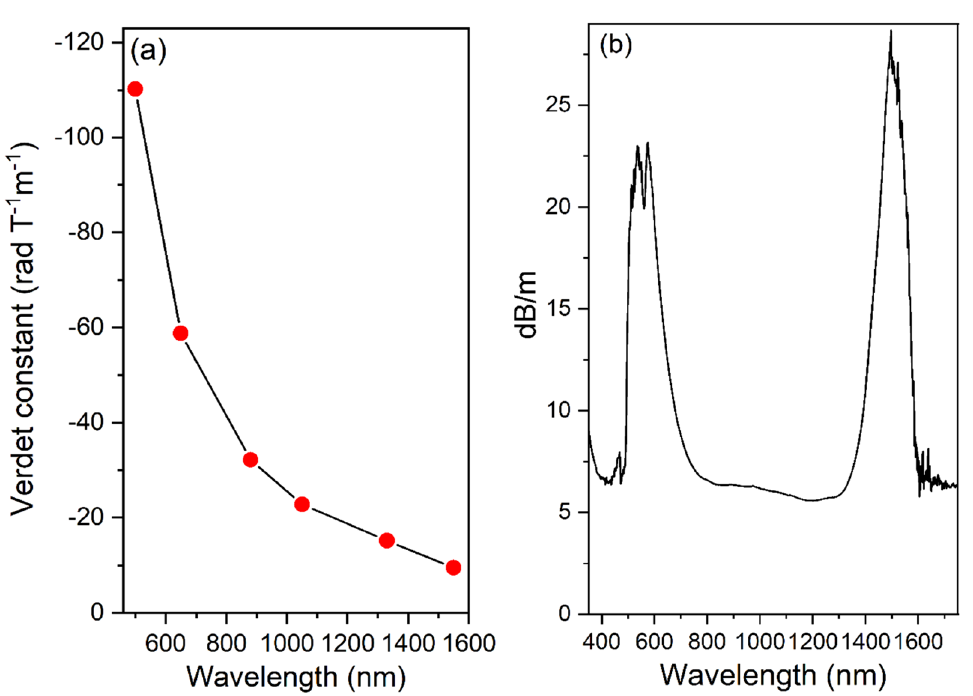
Figure 10. ( a ) Variation of the Verdet constant as a function of wavelength and ( b ) attenuation spectrum of the BGB-8Tb fiber determined using the cut-back method, with a final length of 0.21